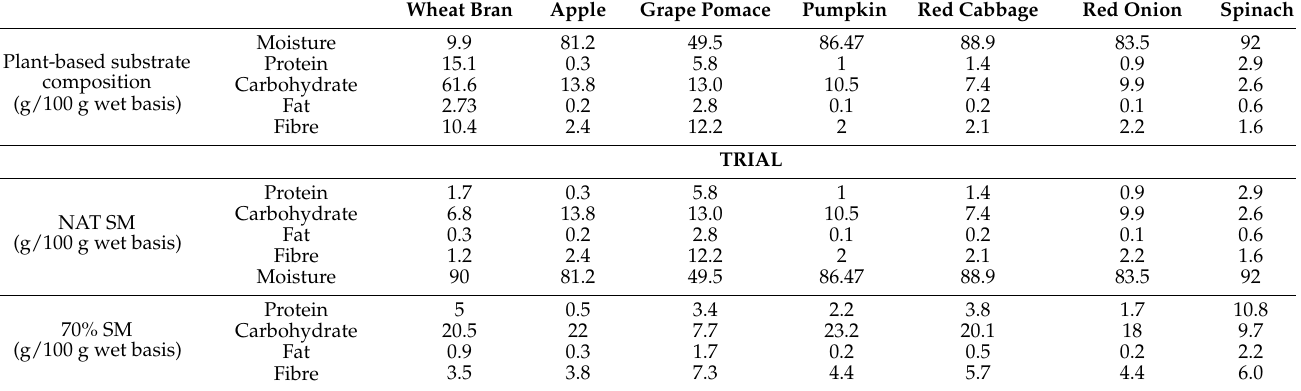
Table 1. Estimated nutritional composition of the plant-based substrates used in the trial under natural conditions (NAT SM) and under optimal substrate moisture conditions (70% SM) [41,42].